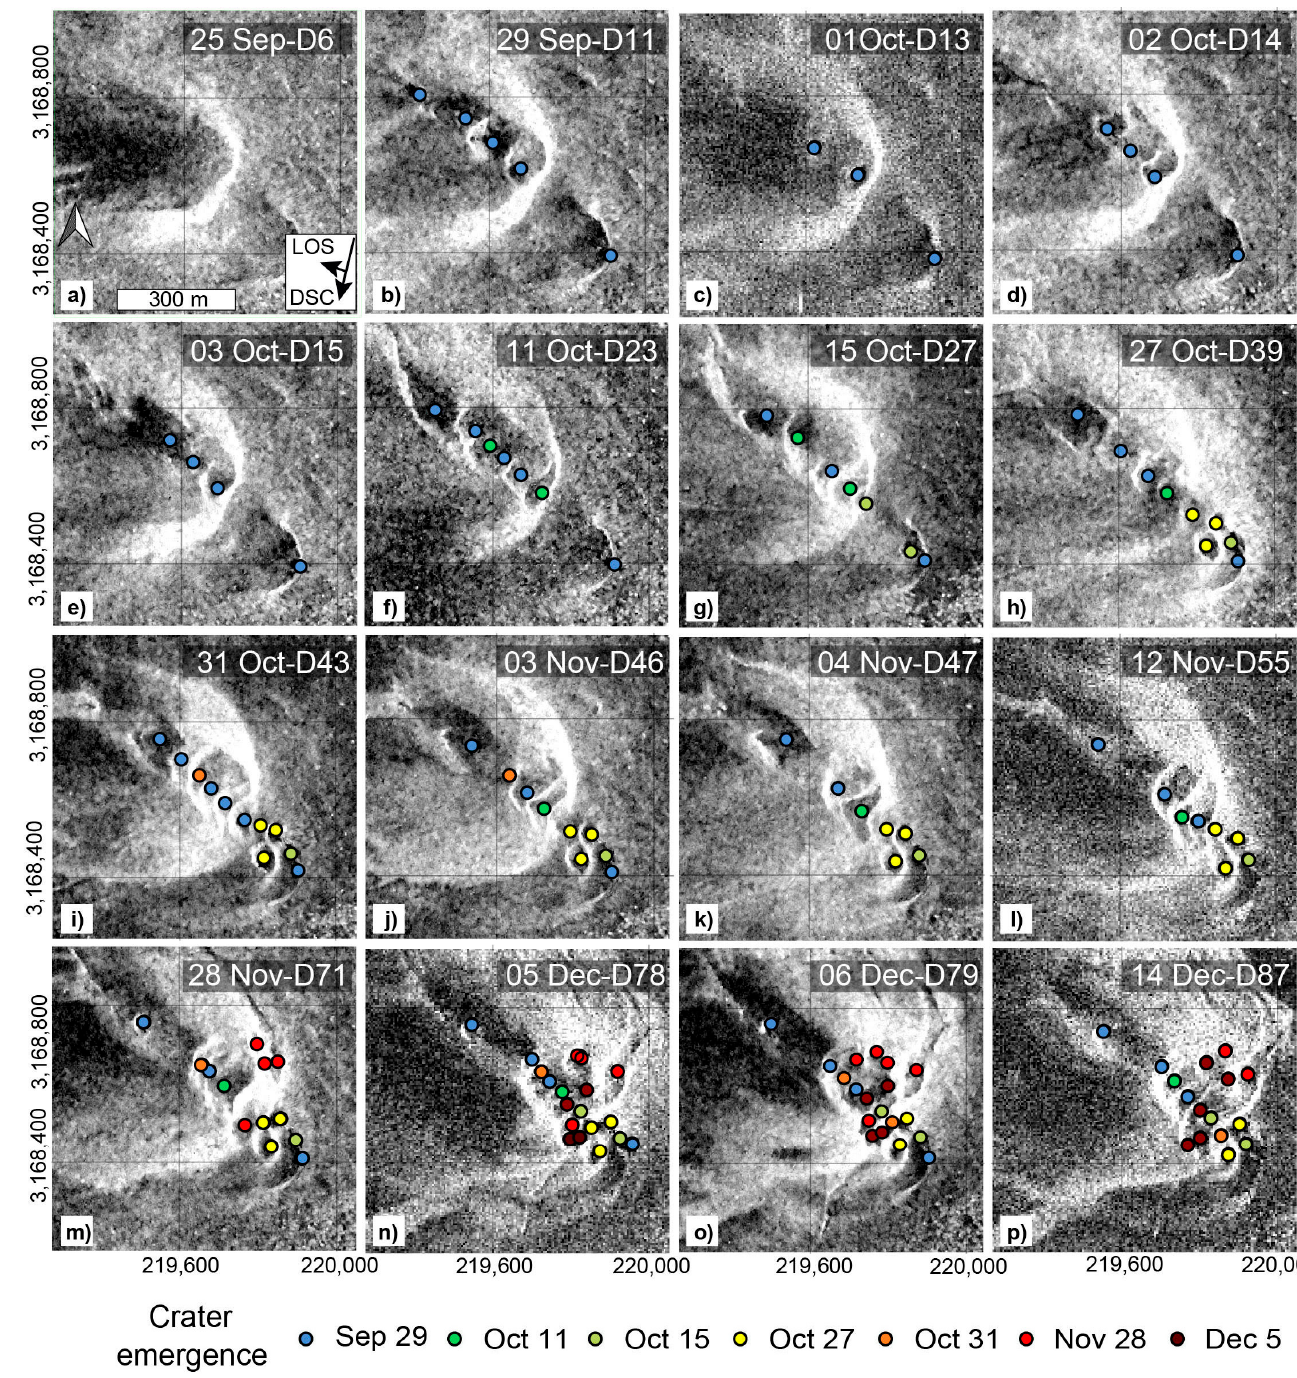
Figure 4. Crater evolution according to the SAR amplitude images acquired in descending orbit. In the panels, we see the chronological emergence of the craters during the eruption of the new Tajogaite cone. The image date and corresponding number of days from the beginning of the eruption are denoted on the upper right side of each image. The colored dots represent each of the visible craters, color coded by the date of the first crater appearance in the SAR image (cold colors are older, warmer colors are later crater ages). Three phases can be distinguished: ( a – g ) a linear crater row defines Phase 1; ( h – l ) a southeastwardly propagating and broadening crater cluster defines Phase 2; ( m – p ) a strongly nested and dispersed crater appearance and formation of a N–S trend define Phase 3.